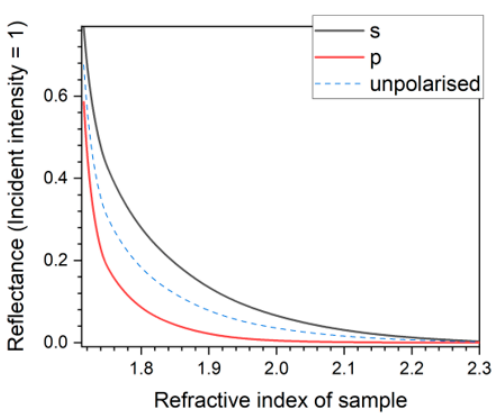
Figure 2. The normalised reflectance at the diamond/sample interface, diamond, n 1 = 2.40. There is significant change in the reflectance in the region of the refractive index of the sample, n 2 = 1.72 to 1.90 giving good contrast.